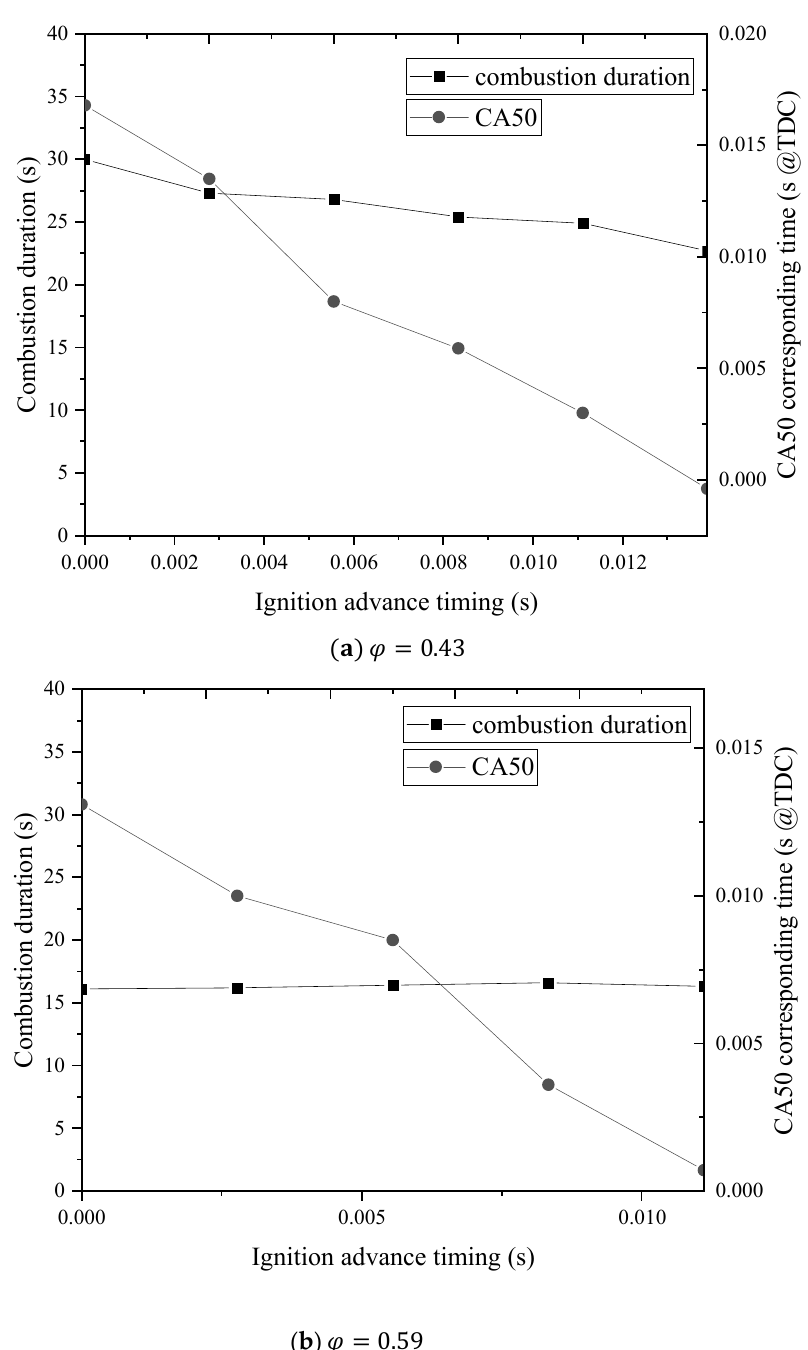
means that the leaner the mixture is, the greater the contribution of ignition advance timing vance timing to shortening the combustion duration would be. to shortening the combustion duration would be.